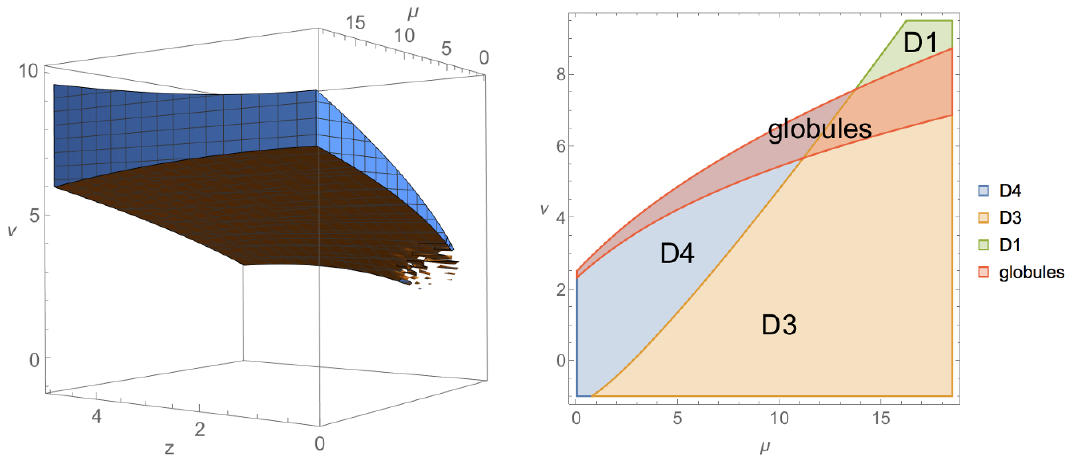
Figure 30 . On the left, the 3d plot of the region (blue) where black globules are present, and (on the right) a section of the plot where the value of z is (cid:12)xed to z = 1 : 5. One can see that increasing the charge z the volume of the region where globules are present grows as